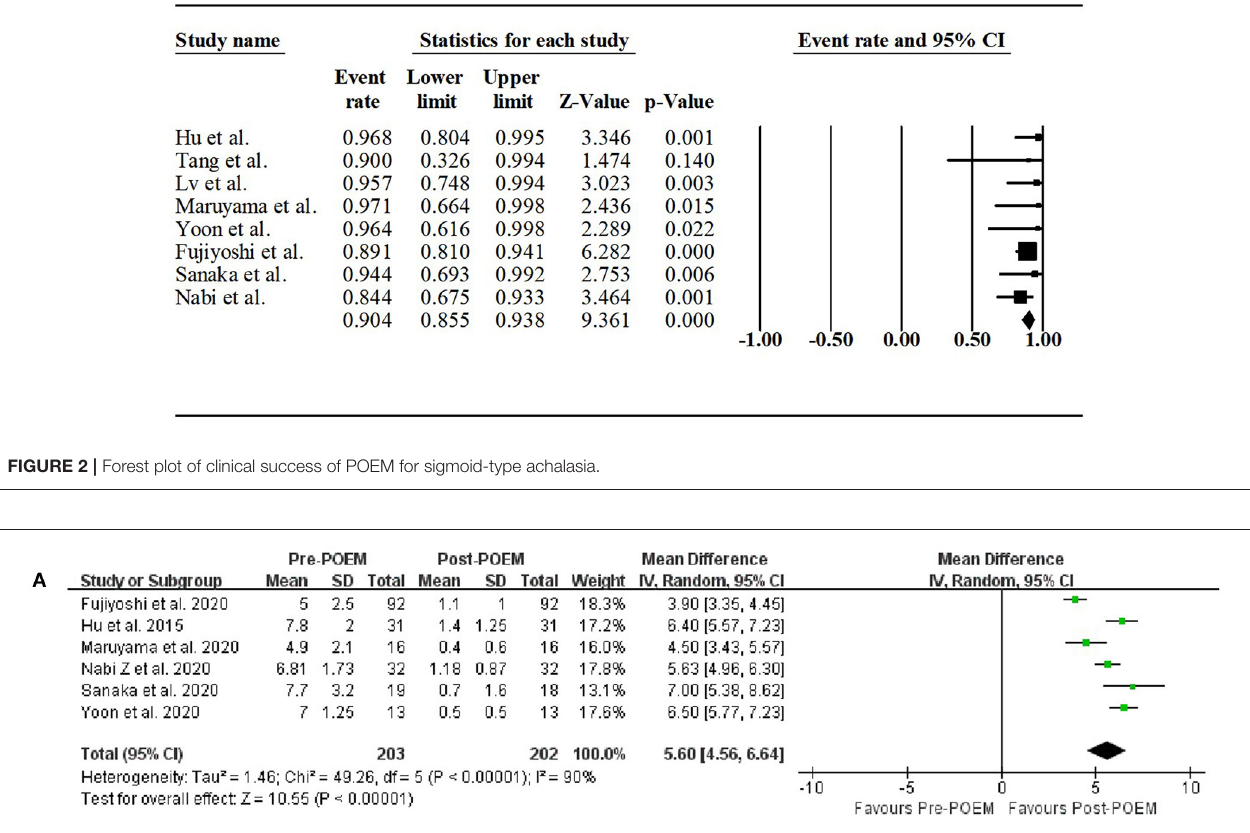
this meta-analysis, we found that: (1) the pooled clinical success for sigmoid-type achalasia patients was 90.4%; (2) the pre- and post-POEM Eckardt scores, angle of esophageal tortuosity, diameter of esophageal, LES pressure, and IRP were significantly improved; and (3) the pooled adverse events rate was